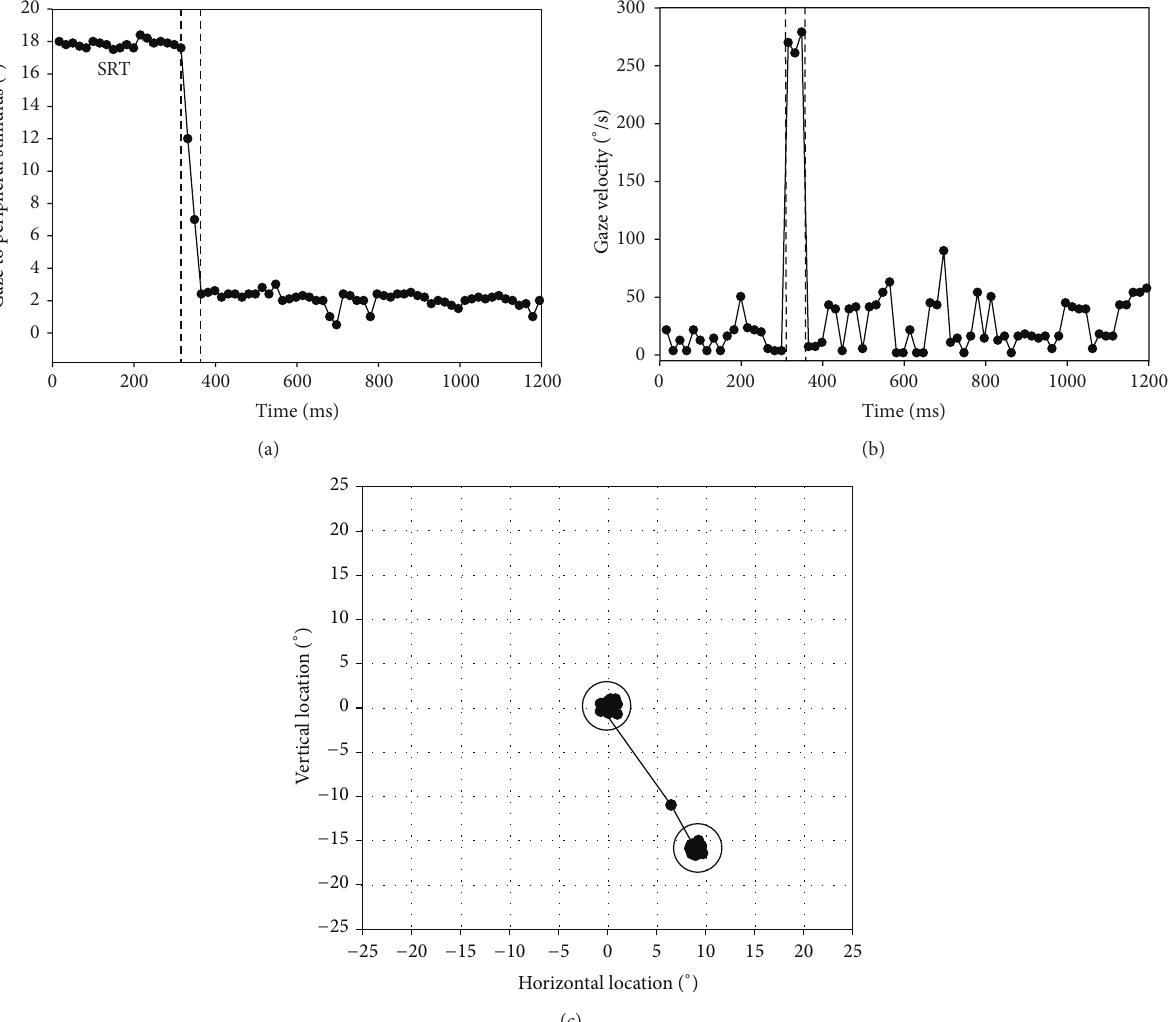
Figure 2: Offline processing interface showing the gaze path of a single trial. Panel (a) shows the gaze location of the subject. At ∼ 360ms an accurate saccade is made towards the stimulus. Panel (b) visualizes the eye velocity and shows the saccade and the velocity based saccade onset and end (vertical lines). Panel (c) shows the gaze coordinates on the test grid. The central circle represents the central fixation point area and the peripheral circle the stimulus area. The line depicts the gaze of the subject.